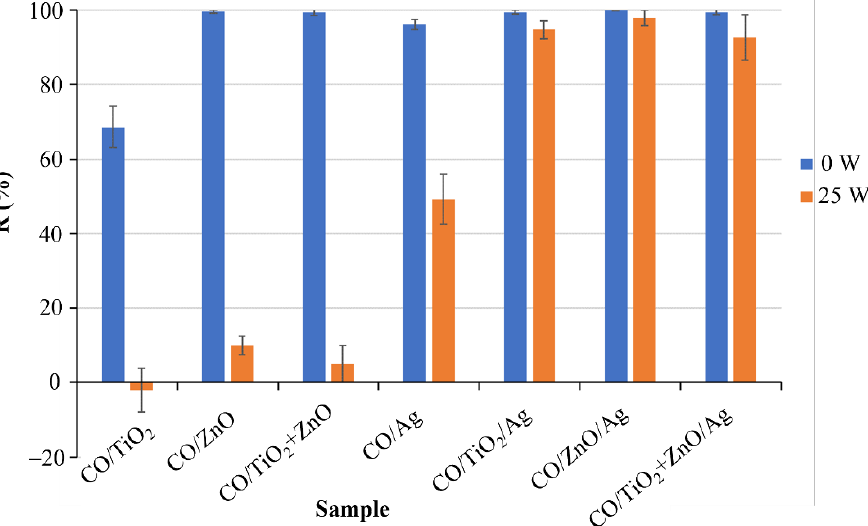
Figure 6. Bacterial reduction, R, of chemically modified cotton samples against E. coli before (0 W) and after 25 (25 W) washings. Table 2. The arithmetic mean of T in the UVA, UVB and UVR ranges; the mean UPF; the UVR protection categories for the untreated and chemically modified cotton samples and the synergistic effect, SE, between the components in the composite